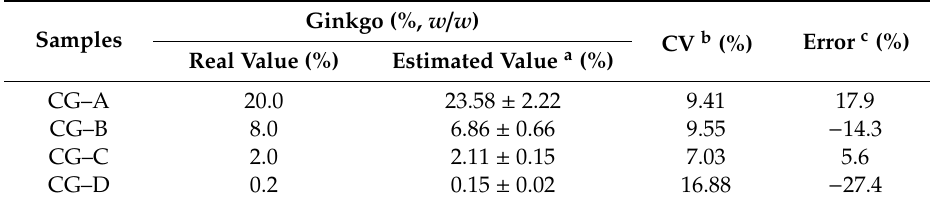
Table 3. Results of the validation assays using the normalized quantitative PCR system applied to blind mixtures of G. biloba in C.